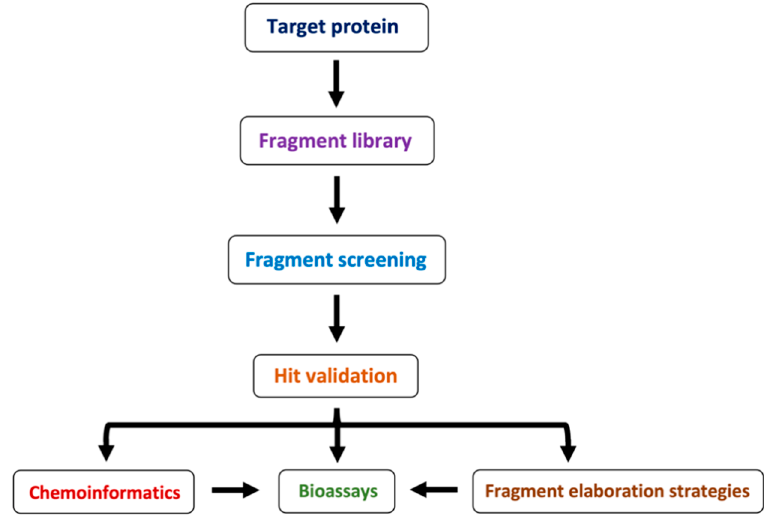
Figure 2. Schematic representation of FBDD methodology.